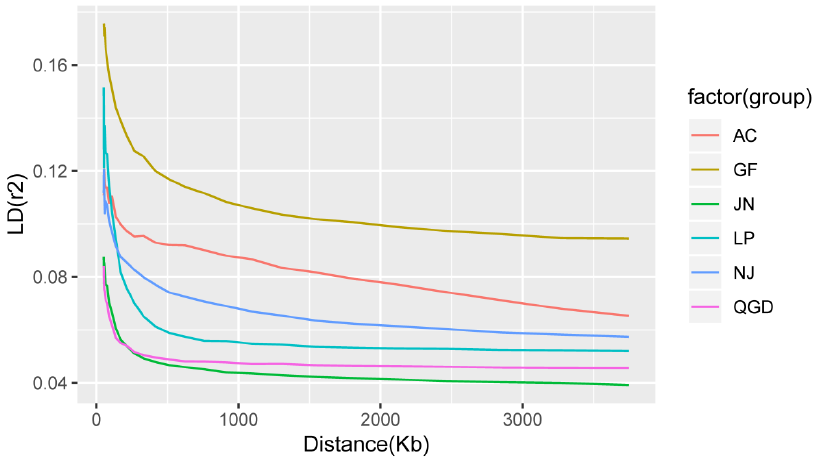
Figure 4. LD decay (r 2 ) from 0 up to 3000 kb for the six Chinese goat breeds.